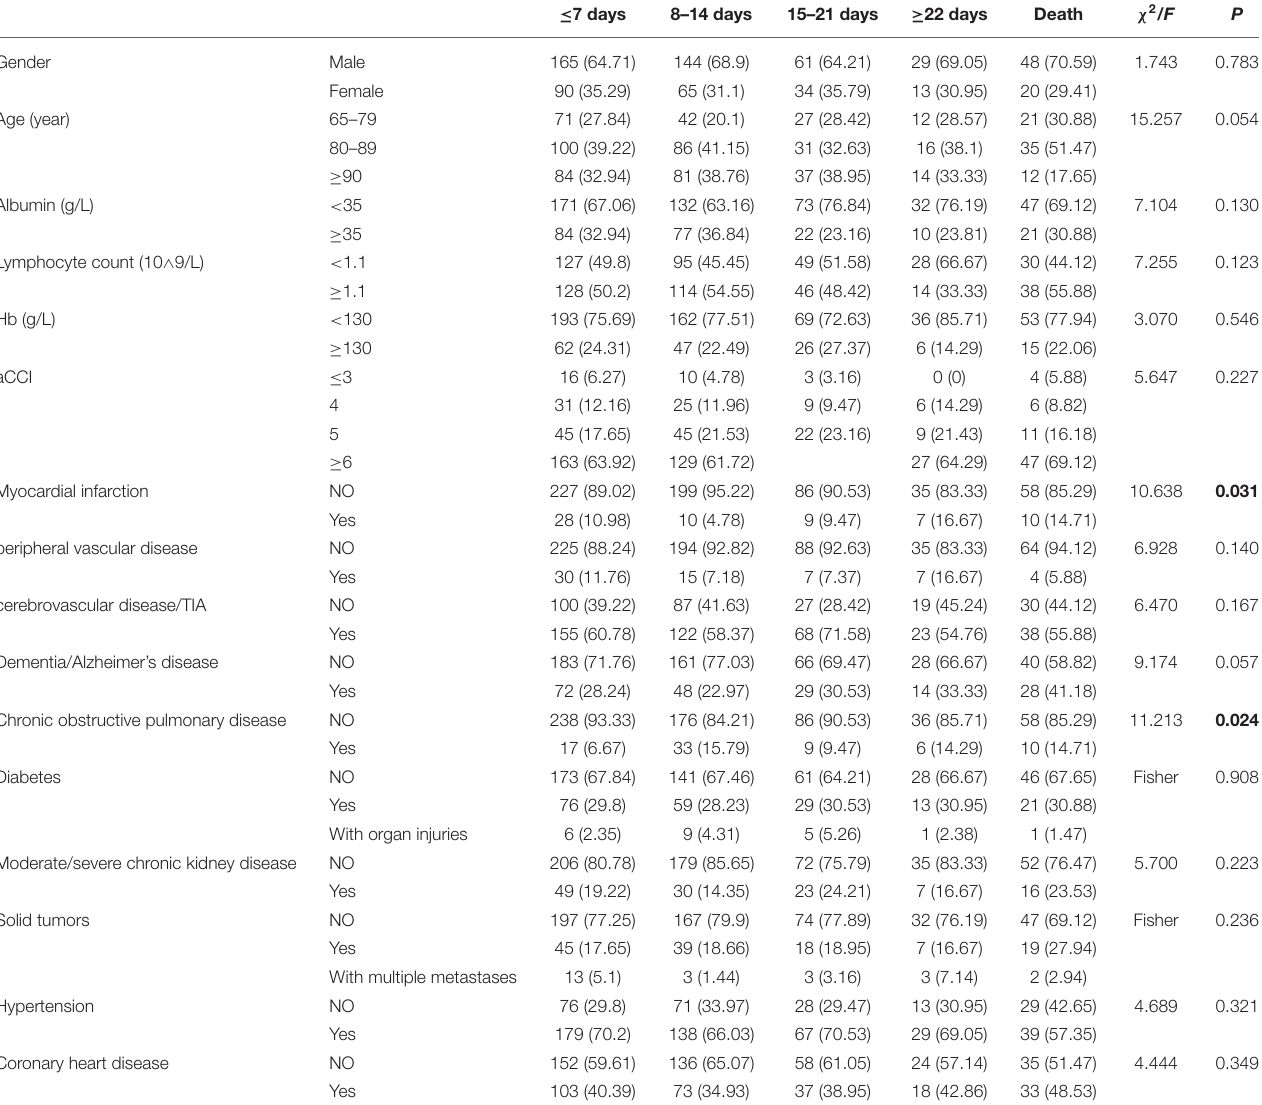
TABLE 1 | Baseline infection